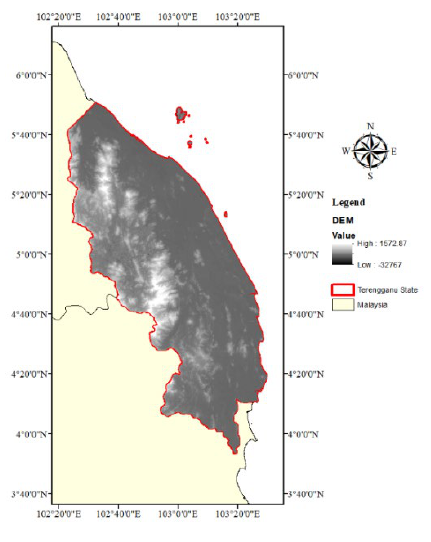
Figure 1. DEM spatial data for Terengganu state